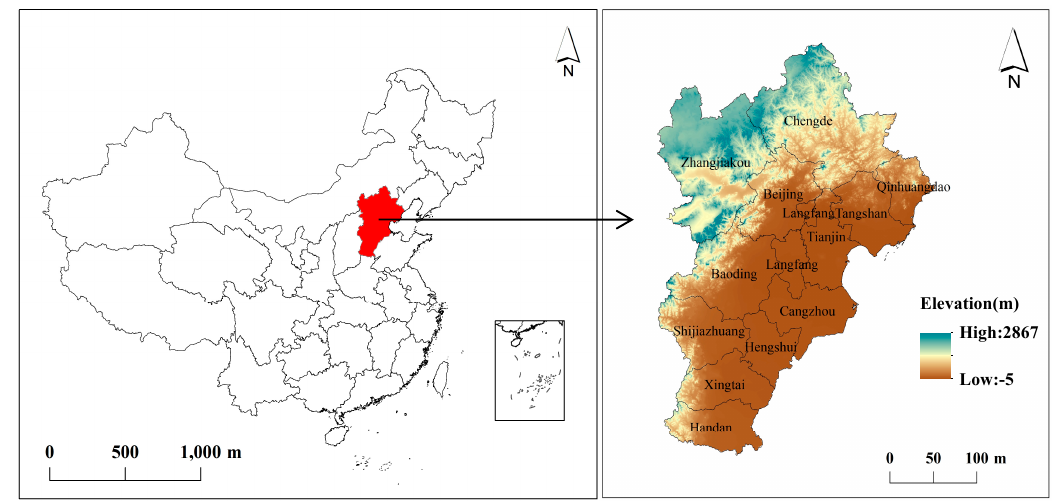
Figure 1. Location and range of the Beijing-Tianjin-Hebei region, China.